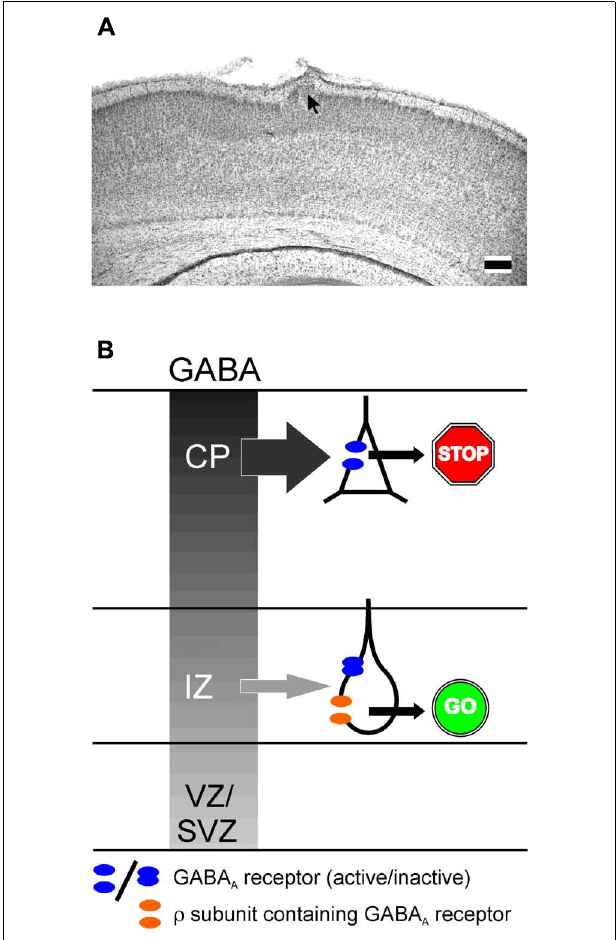
FIGURE 3 | Influence of GABA A receptors on migration. (A) Migration defect induced by GABA A receptor inhibition in vivo . Digital photograph of 50- μ m-thick Nissl-stained coronal sections showing a heterotopia (arrow) of a P7 rat treated with a BMI loaded Elvax implant at P0. Scale bars correspond to 200 μ m. (B) Schematic drawing illustration the effect of classical and ρ subunit containing GABA A receptors on radial migration in the developing neocortex.The gray gradient represents the outside directed GABA gradient. In the intermediate zone (IZ) migrating neurons express classical GABA A and ρ subunit containing GABA A receptors. In the cortical plate (CP) only classical GABA A receptors are found. Due to the outside directed GABA gradient the low-affinity classical GABA A receptors are only activated in the CP, where they contribute to termination of migration (STOP sign).The lower GABA concentration in the IZ is only sufficient to activate the high affinity ρ subunit containing GABA A receptors, which is necessary to support migration in the IZ (GO sign). Modified from Heck etal. (2007) (A) and Denter etal. (2010) (B)